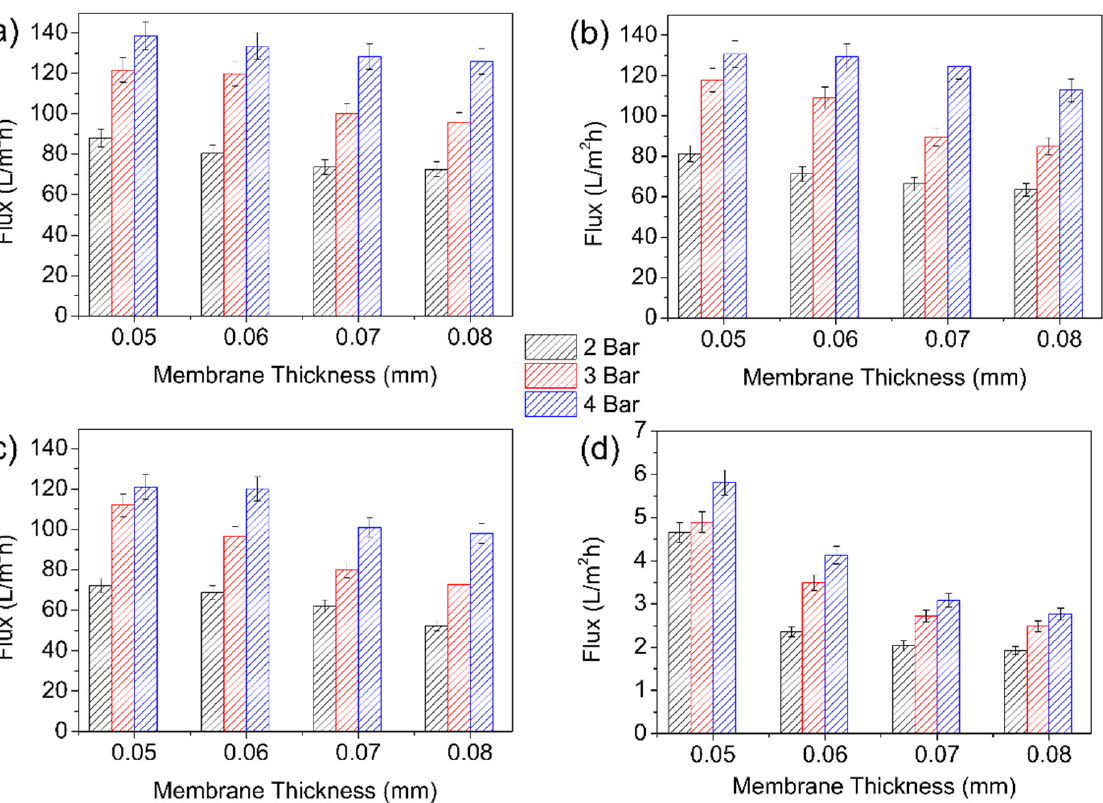
Figure 6. Pressure dependence water flux of nanocomposite membrane using cross-flow method at various membrane thicknesses based on a cross-flow system: ( a ) M0, ( b ) M50, ( c ) M100, and ( d ) M400.